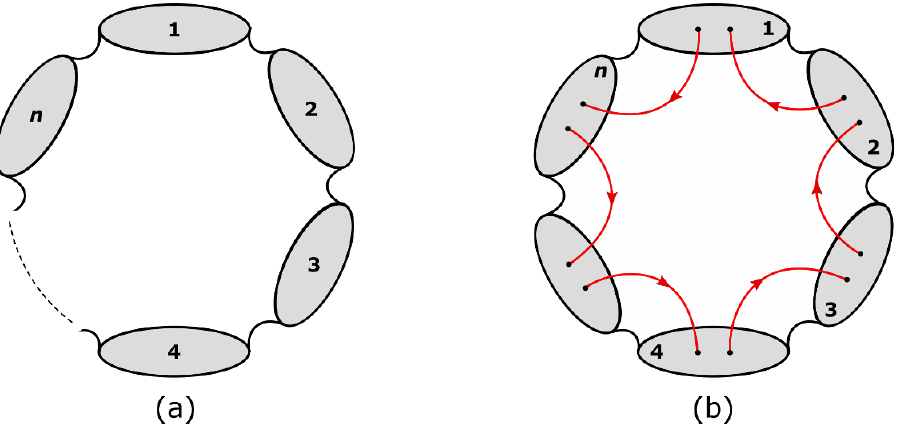
Figure 2 . Manifolds whose boundary consists of n disjoint S 2 components are shown in figures (a) and (b). In figure ( b ), each S 2 has some punctures with Wilson lines stretching from one puncture to